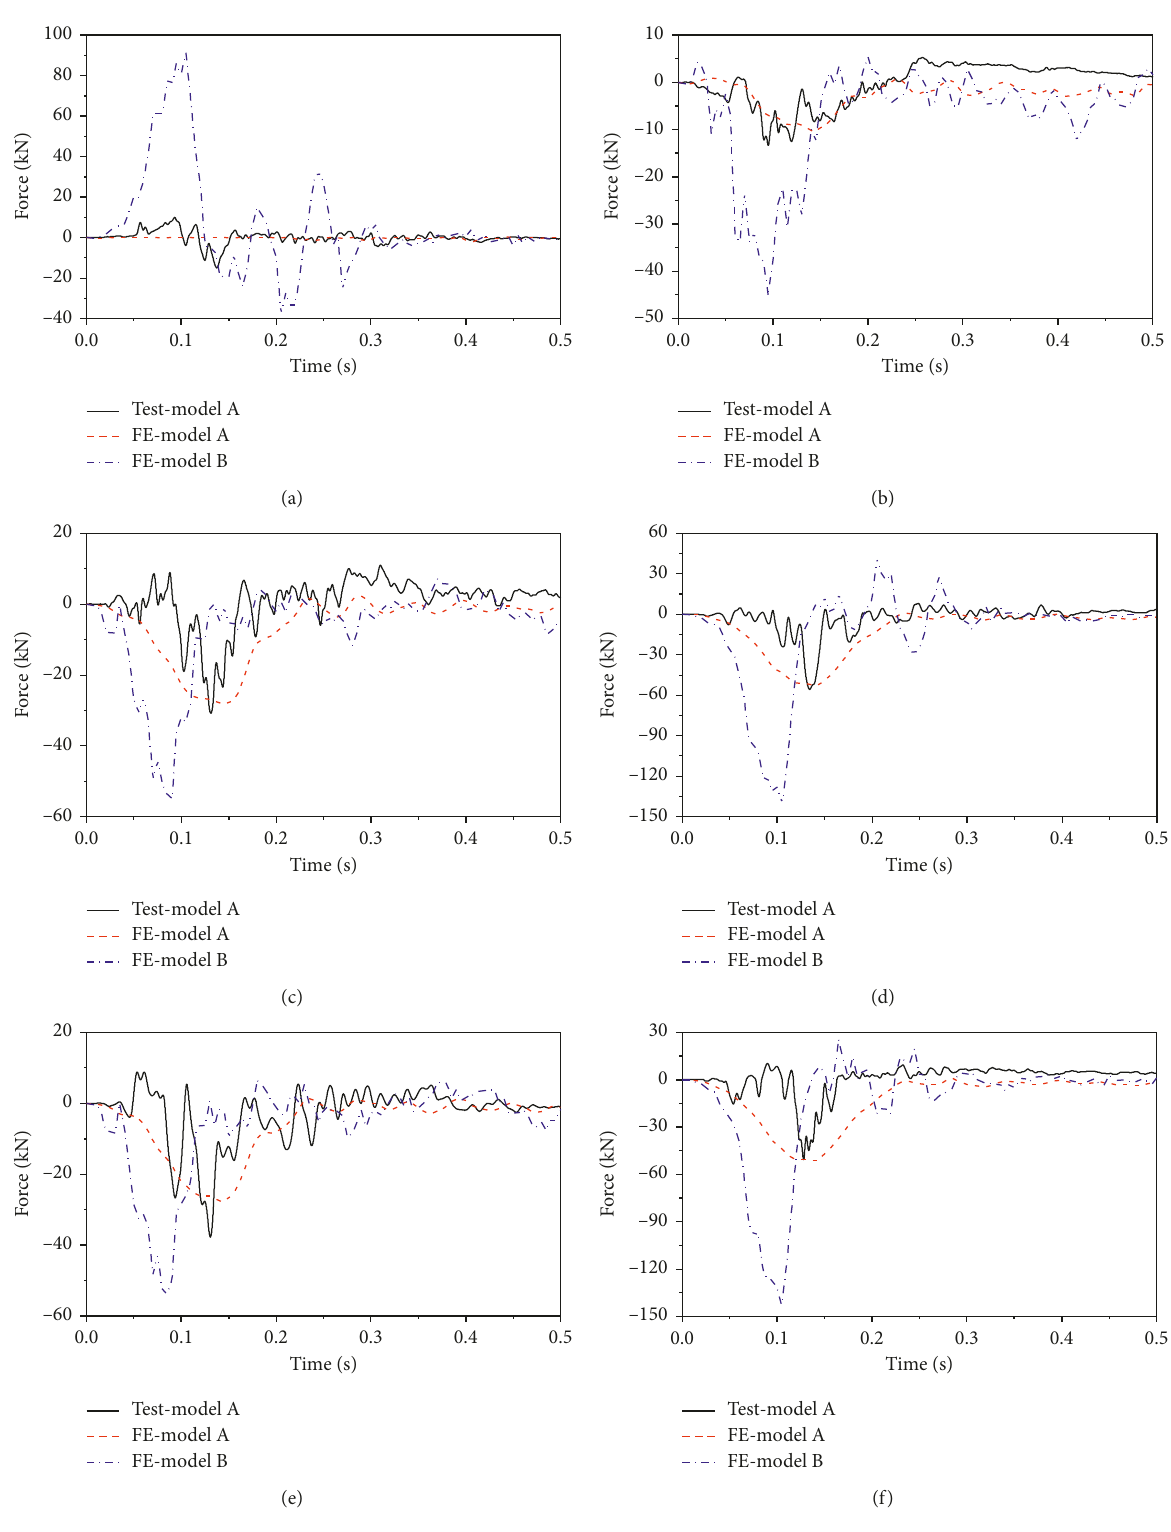
Figure 17: Axial force of spring rods. (a) Measured point S1. (b) Measured point S2. (c) Measured point S3. (d) Measured point S4. (e) Measured point S5. (f) Measured point